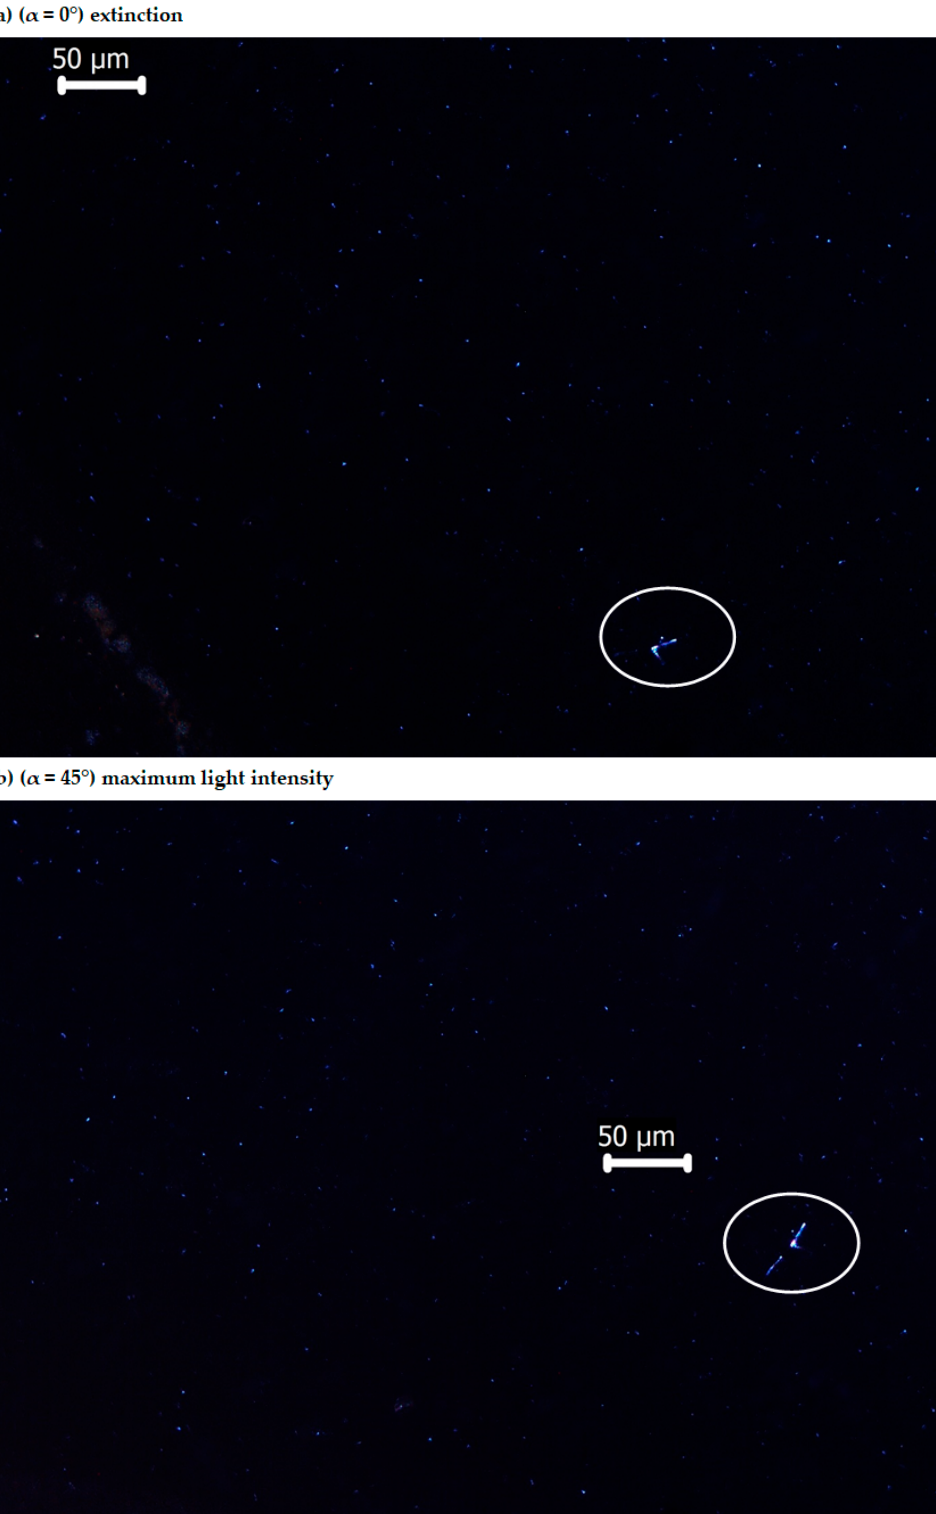
Figure 10. Optical images of BPA ( c = 1%) with crossed polarizers.